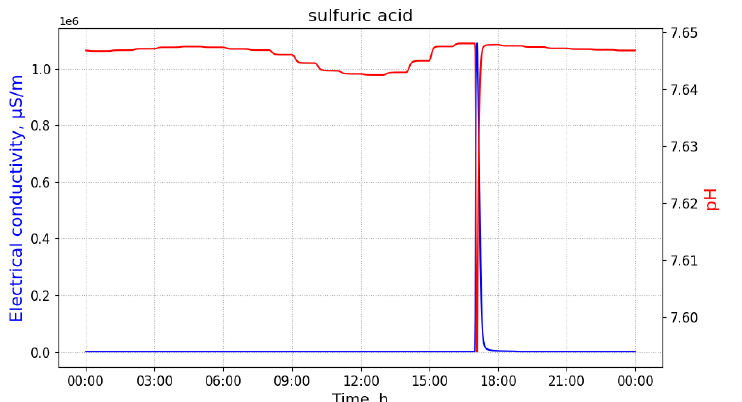
Figure 4. Measurements of pH and electrical conductivity for the utility network content contami- nated with sulfuric acid. The values of the horizontal axis represent time of the day. Measured at the manhole 02, discharged at the building B33 with 100 L of the pollutant at 8 a.m.